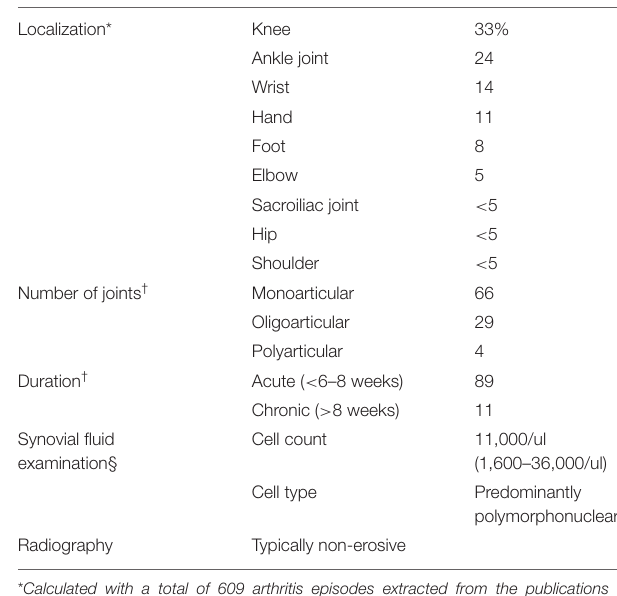
TABLE 2 | Characteristics of arthritis in